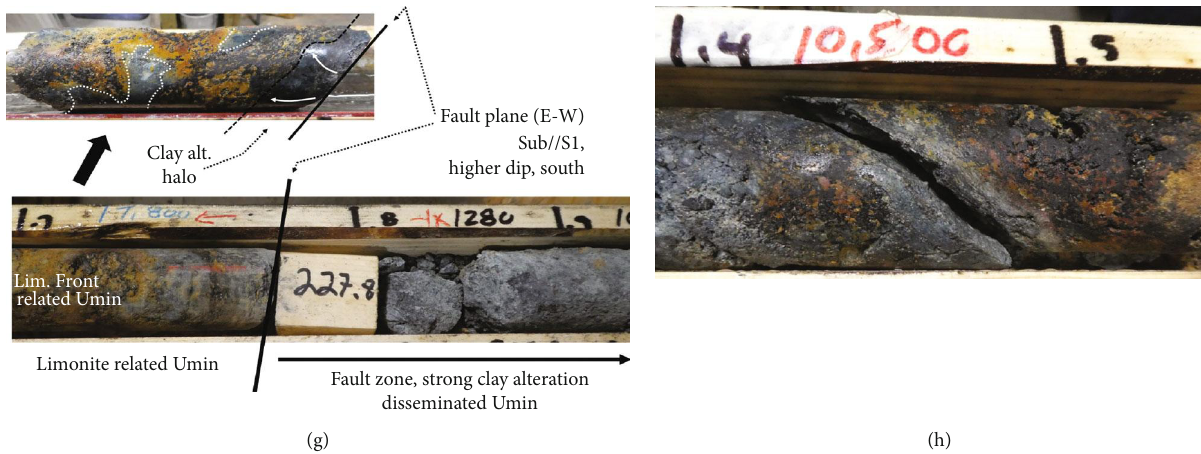
Figure 11: Drill hole ML-134. (a) General overview of the mineralized interval @205.3-249.2m. (b) Microfractures fi lled with secondary graphite or dark chlorite @210.4m, < 830 cps. (c) Fracture and quartz-feldspar segregation-related mineralization @209.8m, < 15.340cps. (d) Limonite oxidation front-related mineralization @217-217.3 m, < 21.630cps. The sketch shows the geometric relationship between the front, the foliation, and the fold. (e) Oxidation front-related mineralization @221.4 to 221.8m, < 11.700cps. The sketch shows the geometric relationship between the front and the foliation. (f) Upper contact of principal mineralization @223.5m. (g) Lower faulted contact of principal mineralization @227.8m. (h) Clay fault @227.4m,